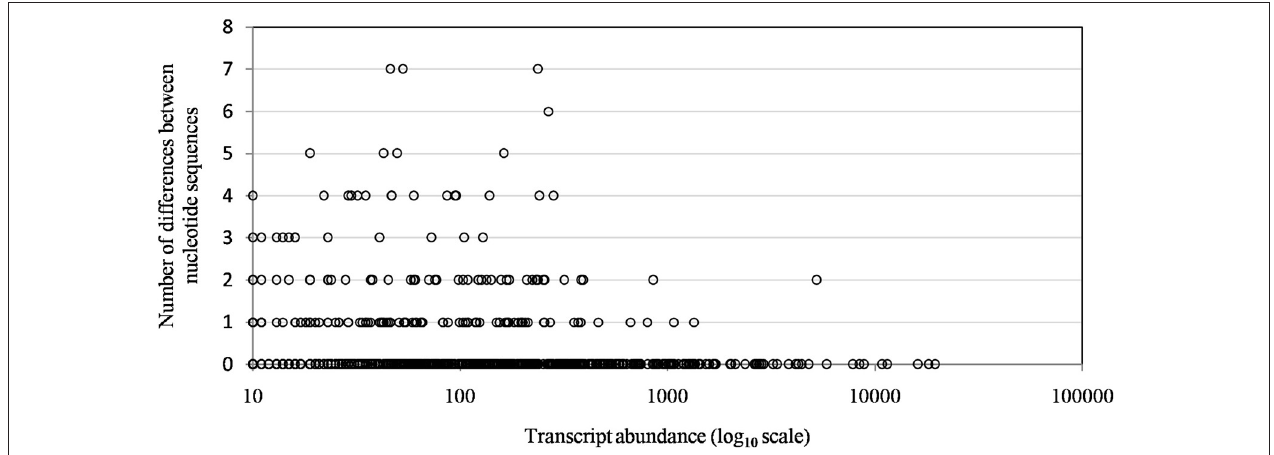
FIGURE 4 | The distribution of transcript abundance for Mimivirus M1 genes according to the number of differences between the nucleotide sequences of the Mimivirus M4 and M1 genes. A difference corresponds